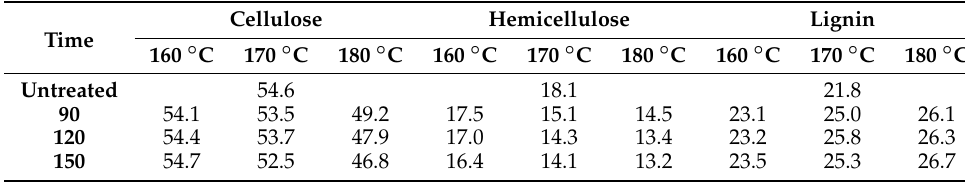
Table 1. Relative content of chemical composition in bamboo samples.